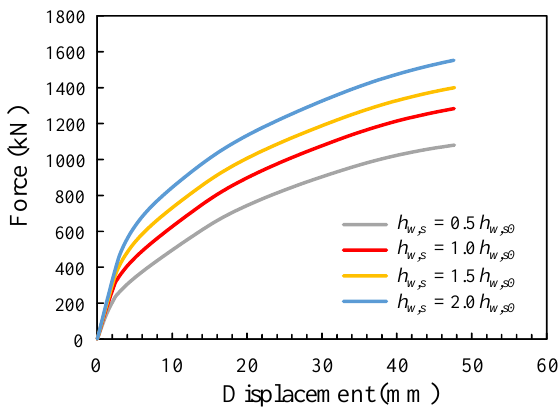
Figure 21. Load–displacement curves for different h w,s values. Figure 21. Load – displacement curves for different h w,s values. Table 6. Comparison of mechanical properties for different h w,s Table 6. Comparison of mechanical properties for different h w,s values.